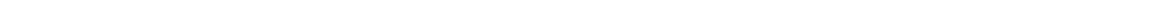
Fig. 2 F-actin fi laments formation and polymerization in a 3D microniche. a Representative images of F-actin staining for hMSCs with different cell volumes and cell geometries after 24 h. b Quanti fi cation of the number of cells forming stress fi bers in a 3D microniche with different sizes and geometries; n = 50 – 60 cells analyzed for each data point. c Immuno fl uorescence images of F-actin and G-actin for hMSCs with different volumes after 12 h. d Quanti fi cation of F- and G-actin levels 12 h after seeding in 3D microniches with different volumes. Total integrated fl uorescence of phalloidin (F-actin) and DNaseI (G-actin) was normalized to the fl uorescence of V 3 cells; n = 40 – 45 cells analyzed for each data point. e Immuno fl uorescence images of F-actin and G-actin for hMSCs with different geometries with V 3 volume after 12 h. f Comparison of normalized mean F- and G-actin intensity in cells with different shapes (cylinder and triangular prism) and aspect ratios (cubic and cuboid); n = 40 – 45 cells analyzed for each data point. g Left: F-actin staining for single hMSCs cultured in 3D microniches with different volumes. Representative cells were selected for each condition. Right: quanti fi cation of the number of cells forming stress fi bers in 3D microniches with different volumes. Colored regions show cell volumes between 2000 ~ 3000, 3000 ~ 4000, 4000 ~ 5000, and > 5000 μ m 3 , respectively. The values of cell volumes were presented on each image. Data are shown as mean ± s.d. for all panels, and * P < 0.05, ** P < 0.01. Scale bar for all images is 20 μ